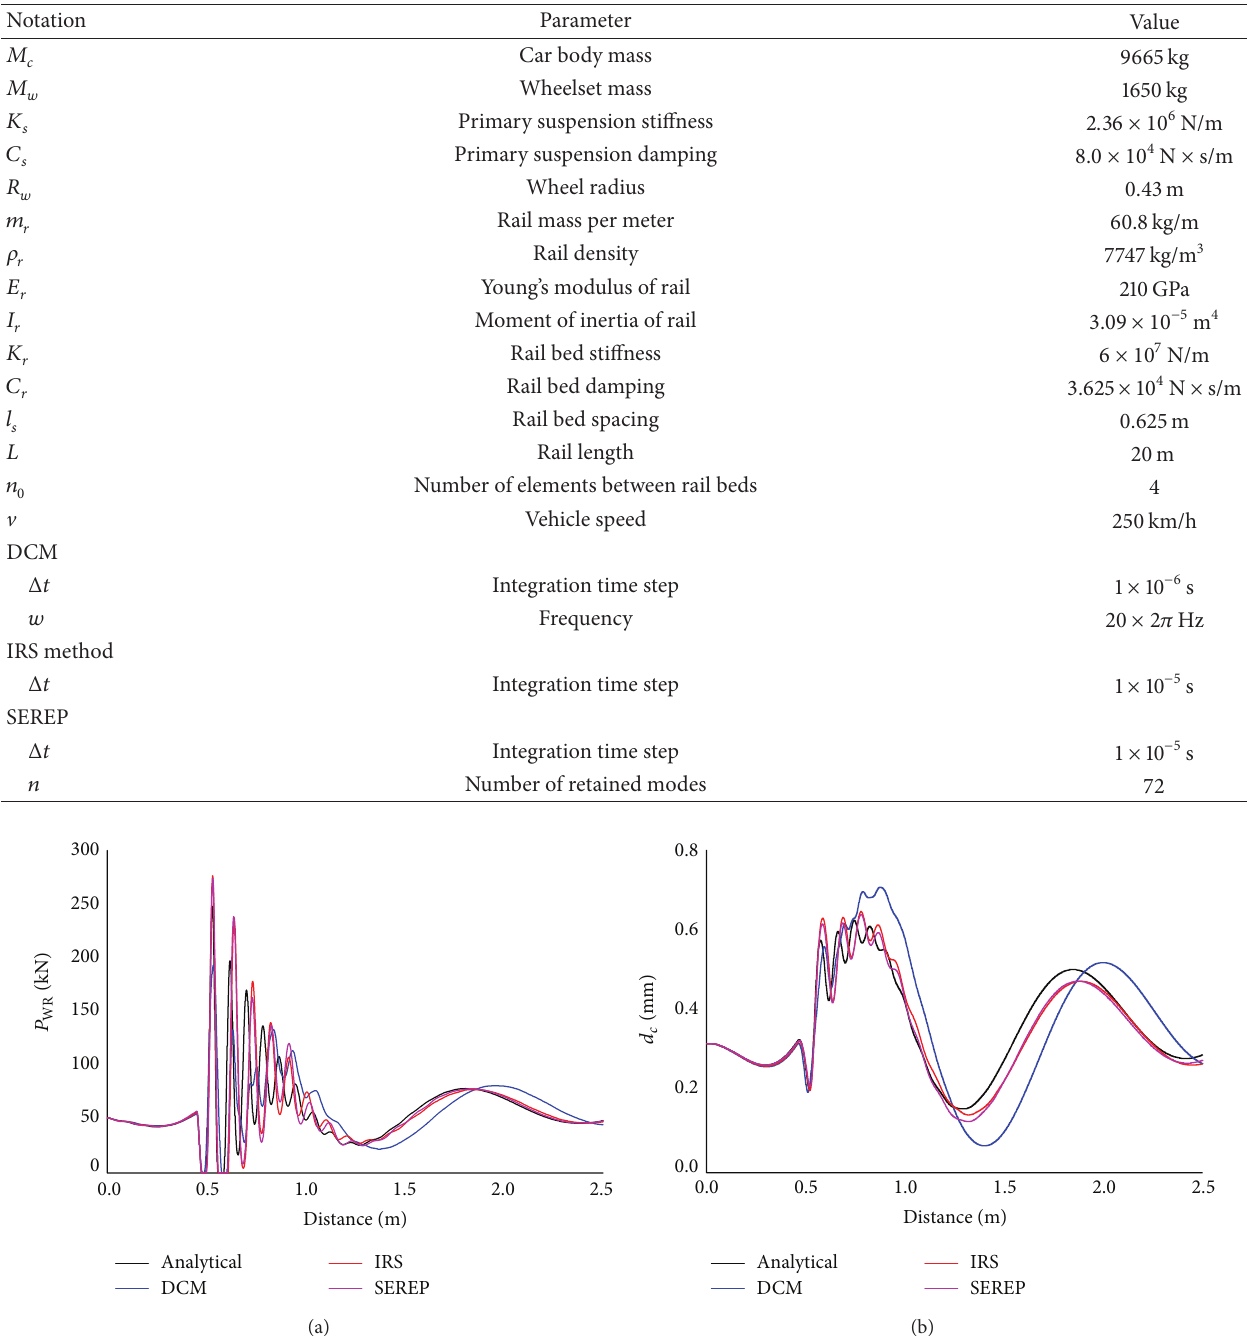
Table 2: Wheel-rail contact model parameters.